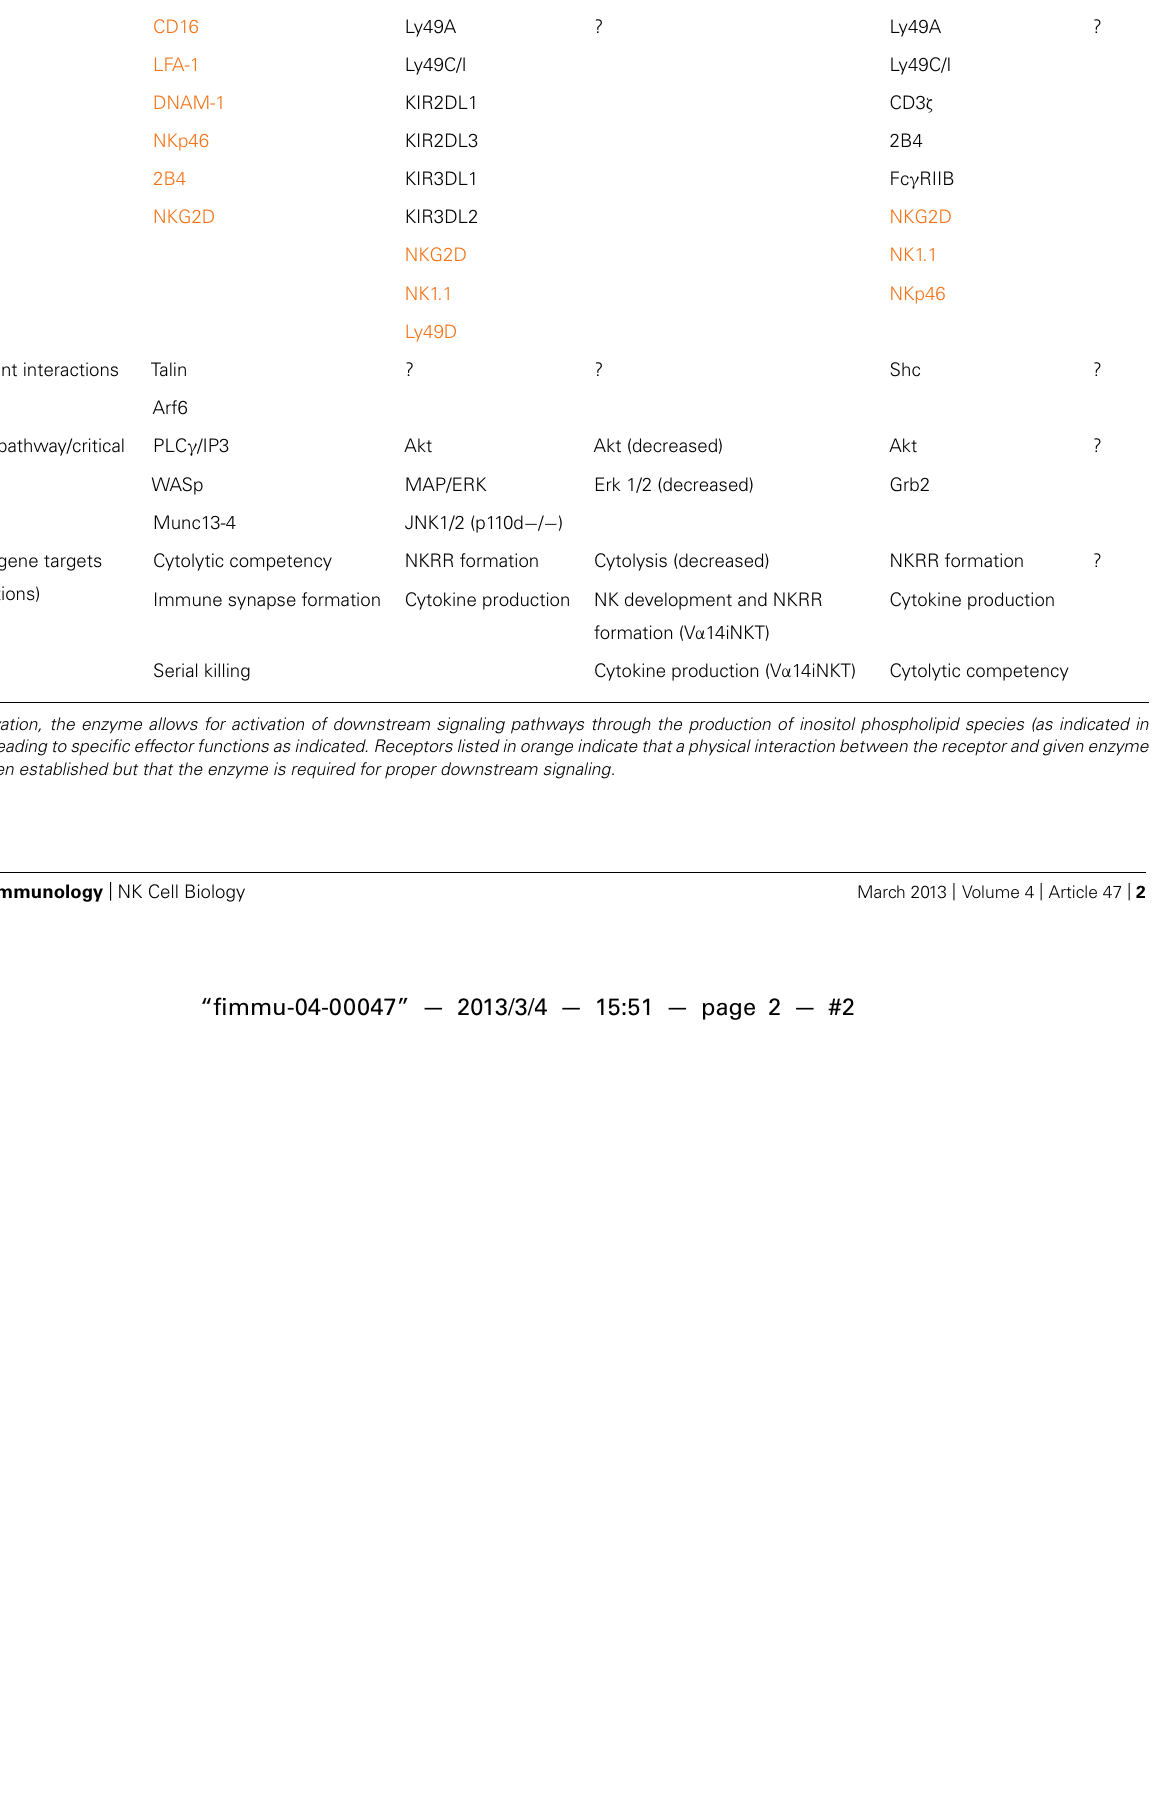
Table 1 | PI modifying enzymes (PIP5K, PI3K, PTEN, SHIP1, and INPP4) are either recruited to or activated following signaling through the indicated NK cell receptor. PIP5K PI3K PTEN SHIP1